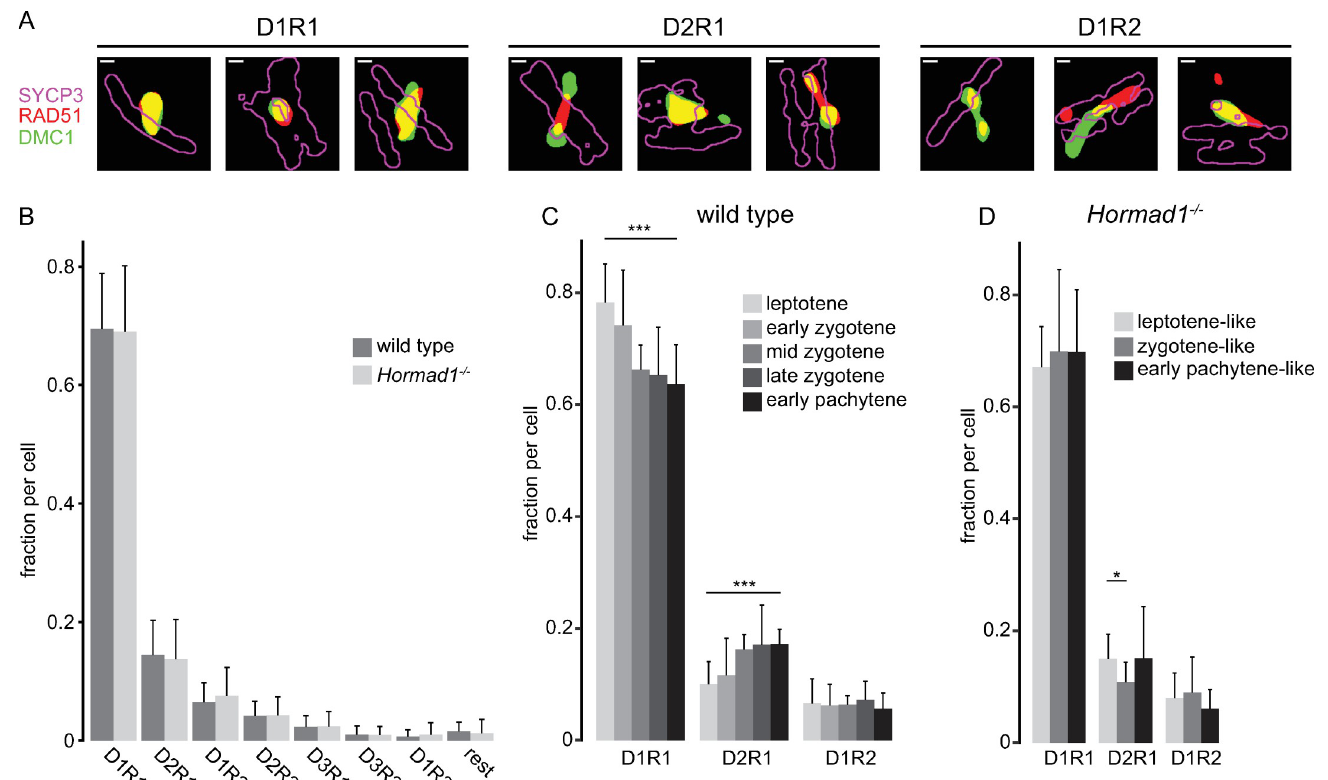
Fig 3. RAD51 and DMC1 configuration in absence of HORMAD1. A) Compilation of three binary representations of kernel density estimation configurations of single ROIs for each of the three main types (left panels D1R1, middle panels D2R1 and right panels D1R2). For SYCP3 only the outline is depicted in magenta, RAD51 is depicted in red and DMC1 in green. B) Barplot of fraction of ROIs with the indicated configuration of RAD51 and DMC1 nanofoci for wild type (n = 55 nuclei) and Hormad1 -/- (n = 36 nuclei). Barplot of fraction of D1R1, D2R1 and D2R1 foci per nuclei per stage for wild type (C) and Hormad1 -/- (D). Scale bars in A represent 100 nm. Error bars indicate standard deviation, p-values can be found in S2